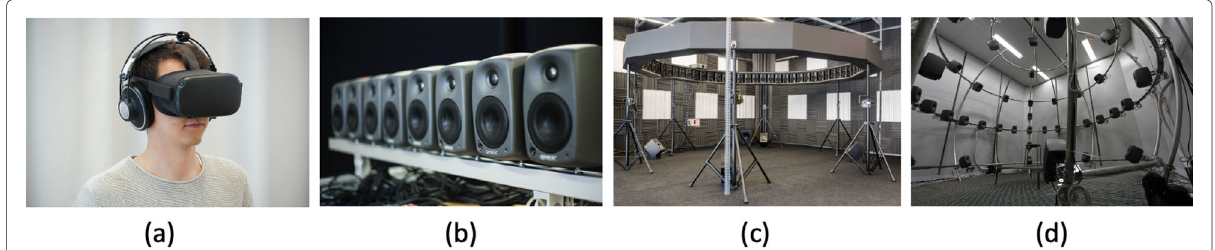
Fig. 3 a Head-tracked dynamic binaural rendering with a head-mounted display (Oculus Quest). b Linear array of loudspeakers at Chalmers University of Technology. c Circular loudspeaker array suitable for 2D spatial audio rendering at University of Valencia. d Spherical loudspeaker array suitable for 3D spatial audio rendering at Aalto